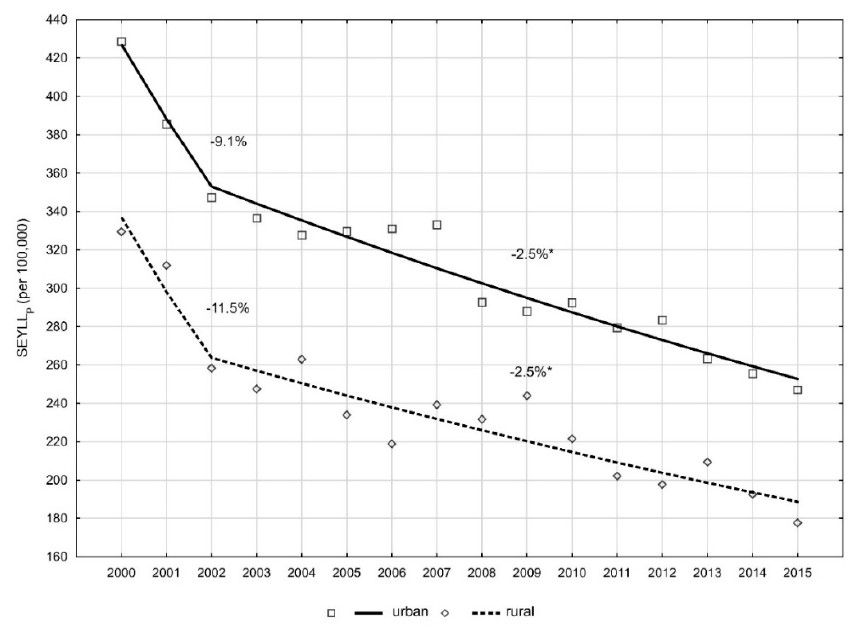
Figure 3. Time trends of the SEYLLp index by place of residence in 2000 to 2015 in Poland. Table 3. SEYLL p and SEYLL p Ratio (SR) by level of education and place of residence, 2000 and 2015, Poland.